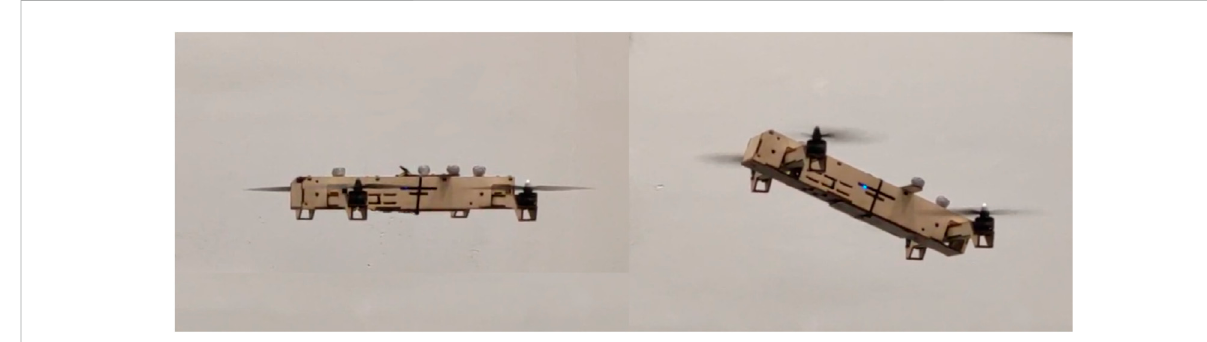
FIGURE 1 The experimental vehicle hovering in the untilted (left) and tilted (right) con fi gurations.